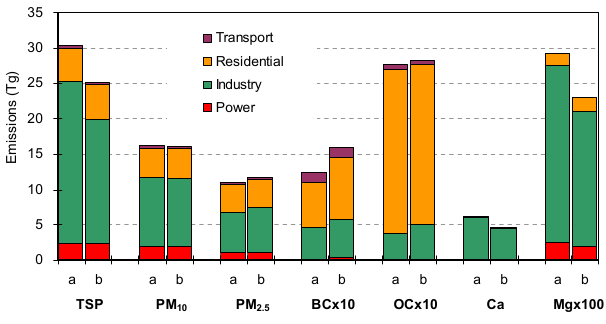
Fig. 12. Comparison of emission estimates for 2001 in (a) this study and (b) our previous results from Zhang et al.,